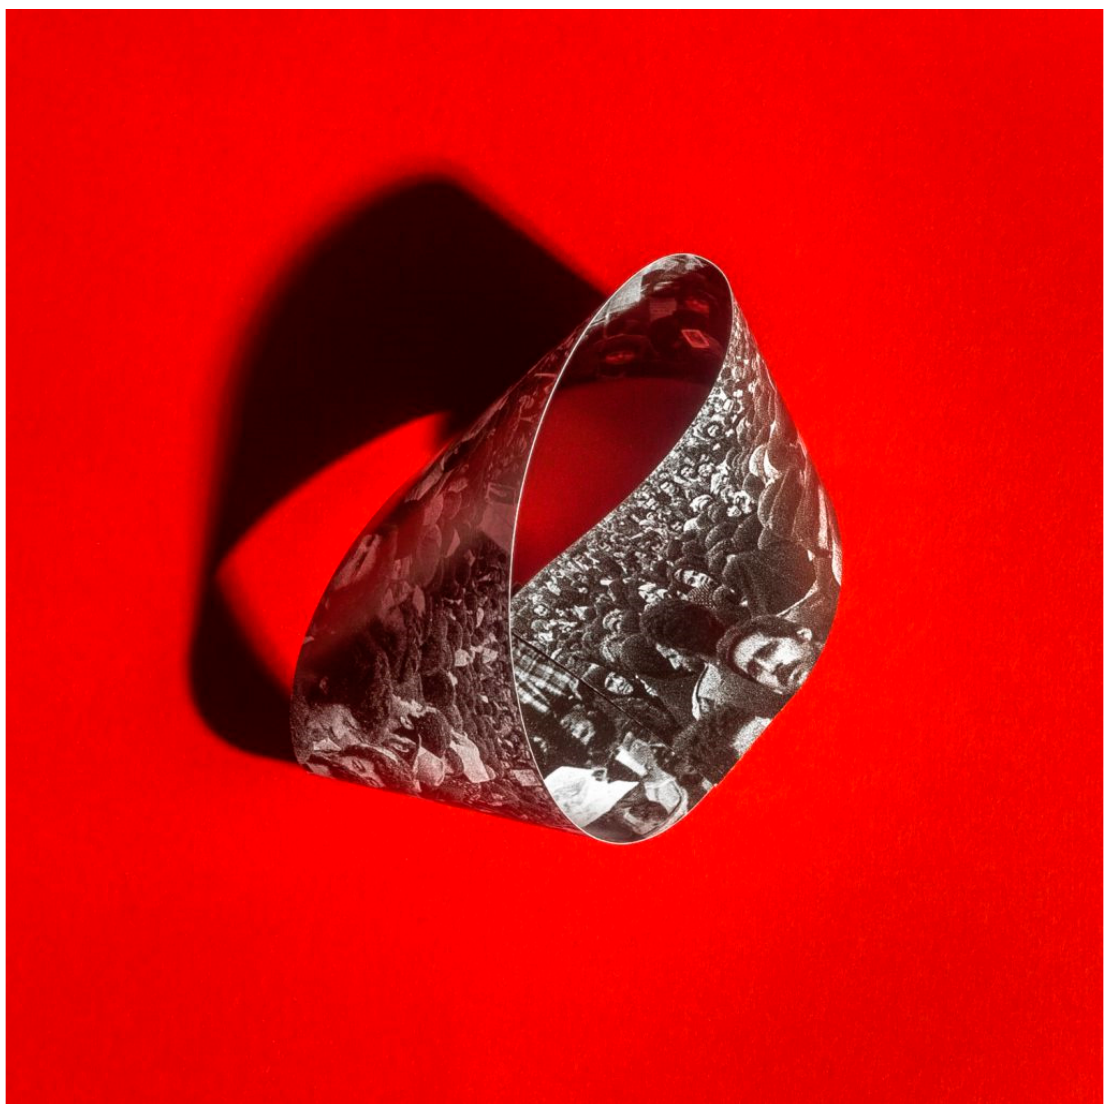
Figure 4. Parham Taghioff, From the Asymmetrical Authority series, 2018, photographs, HD inkjet print on archival acid-free paper, 50 × 50 cm.